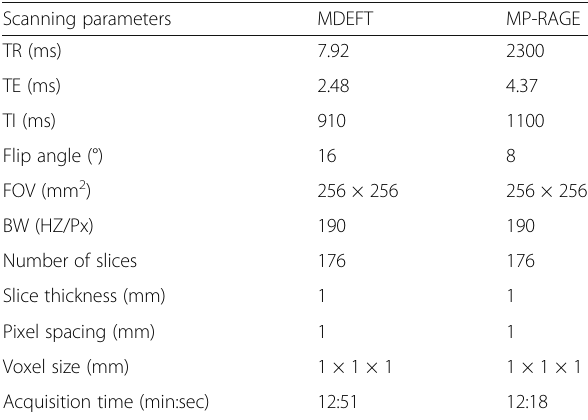
Table 1 Scanning parameters for 3D T1-weighted images: